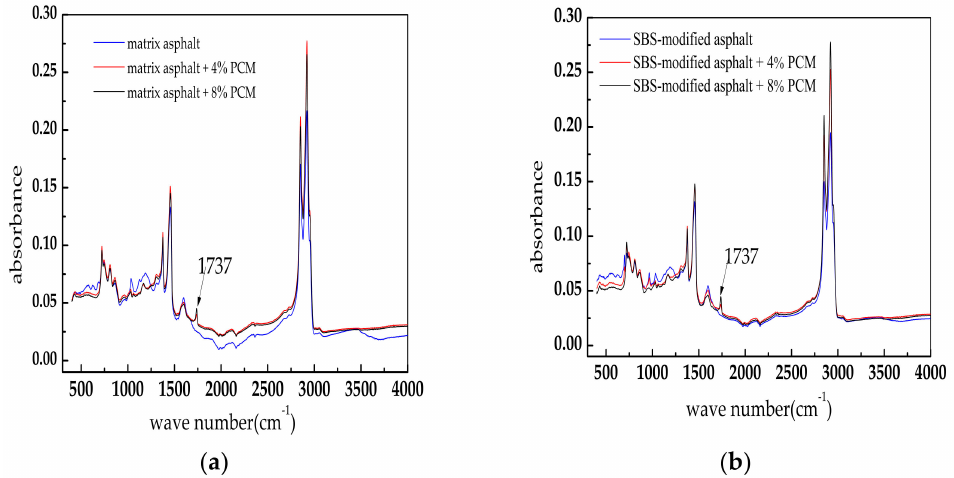
Figure 4. FTIR spectra of asphalt samples before and after modification. ( a ) matrix asphalt samples; ( b ) pure SBS − modified asphalt